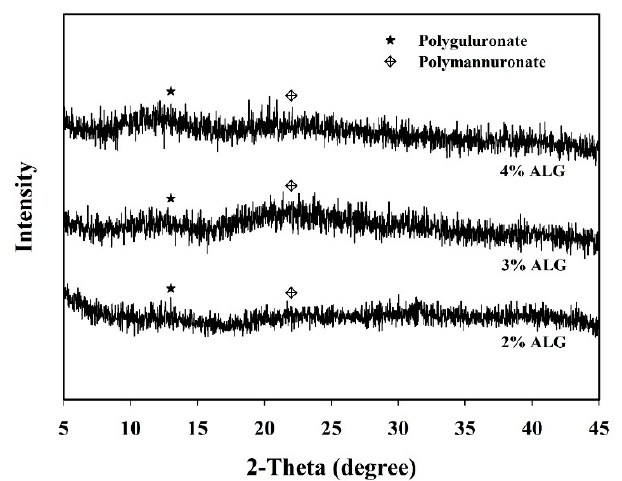
Figure 3. XRD patterns for the capsules loaded with L. plantarum BCRC 10357 by using different concentrations of sodium alginate (% ALG).